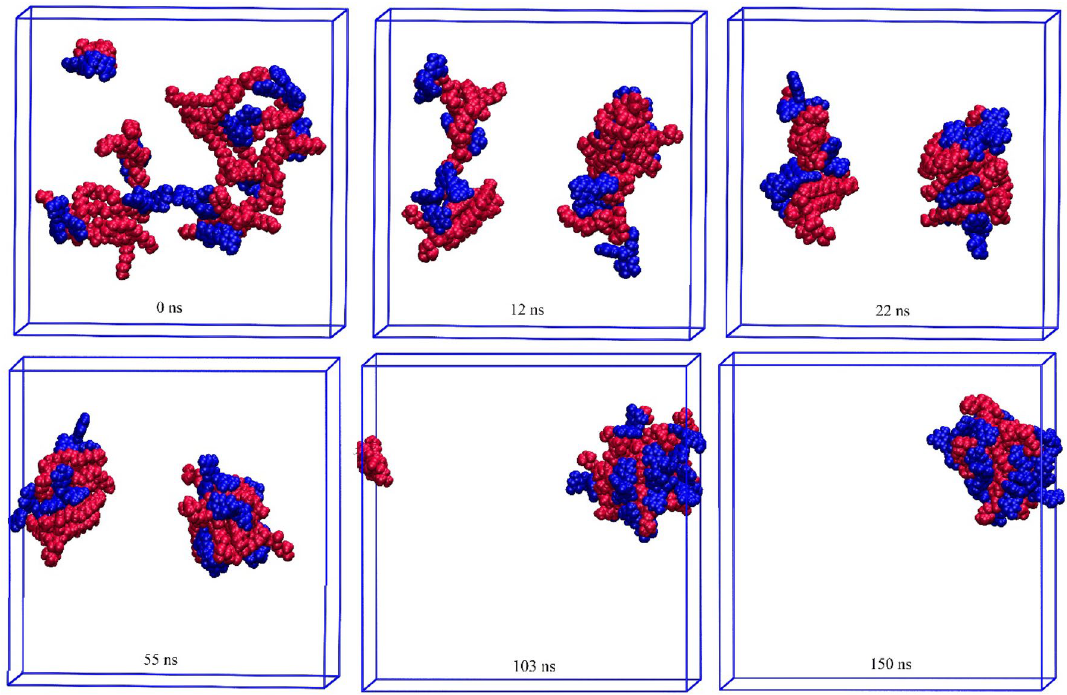
Figure 10. Self-aggregation process of Eg-PC monomers into a phytosome as a function of MD simulation time. Color code; EG: blue and PC: red.